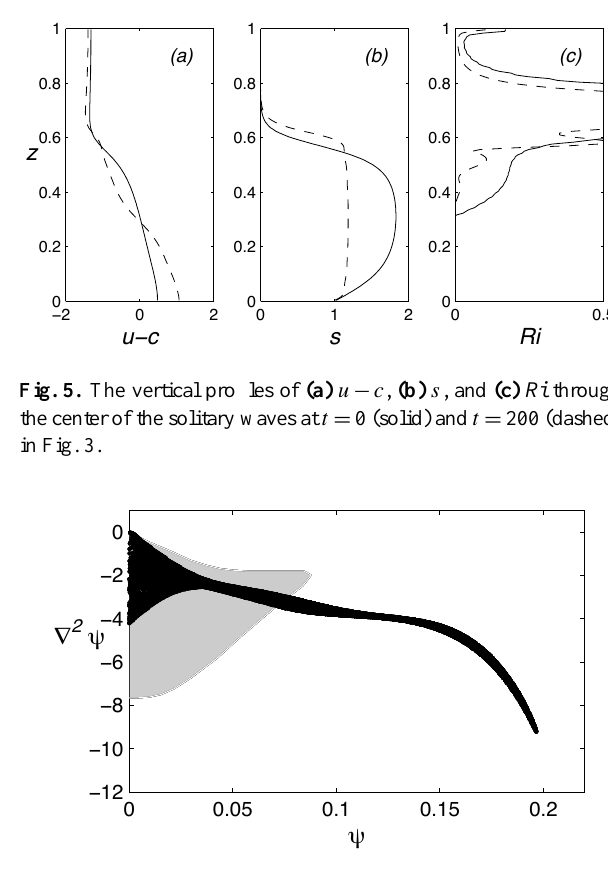
Fig. 6. Scatterplot (black) of the core vorticity versus streamfunc- tion at t = 200 for the case in Fig. 3. The light gray region indicates the values of streamfunction and vorticity in the core at t =